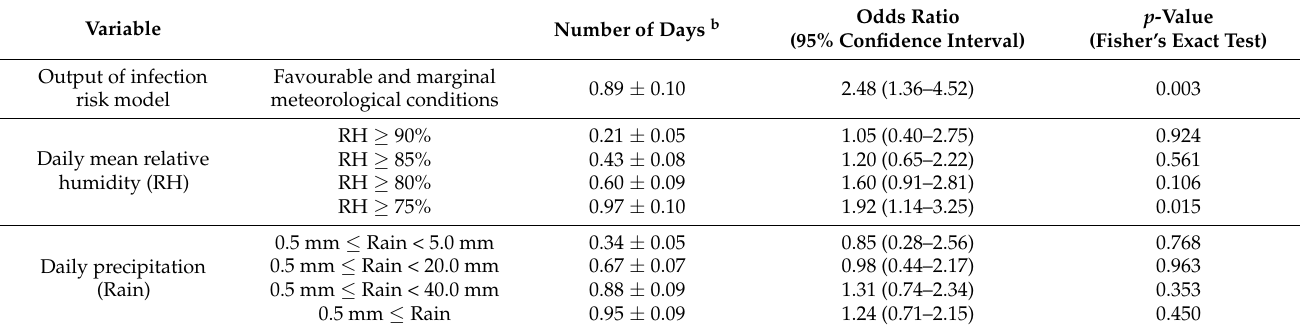
Table 4. Relationship between the meteorological conditions during the 3-day putative infection period and the probability of disease development of onion downy mildew by binary logistic regression a .